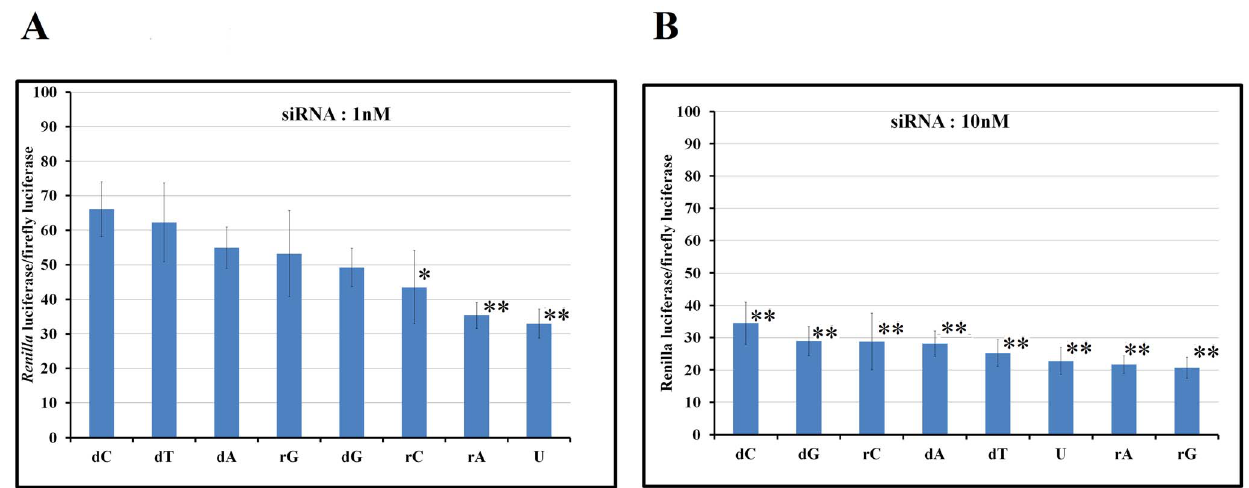
Figure 3. Dual luciferase assay. The materials and conditions are described in the Methods section. *Significant at 0.05 level. **Significant at 0.01